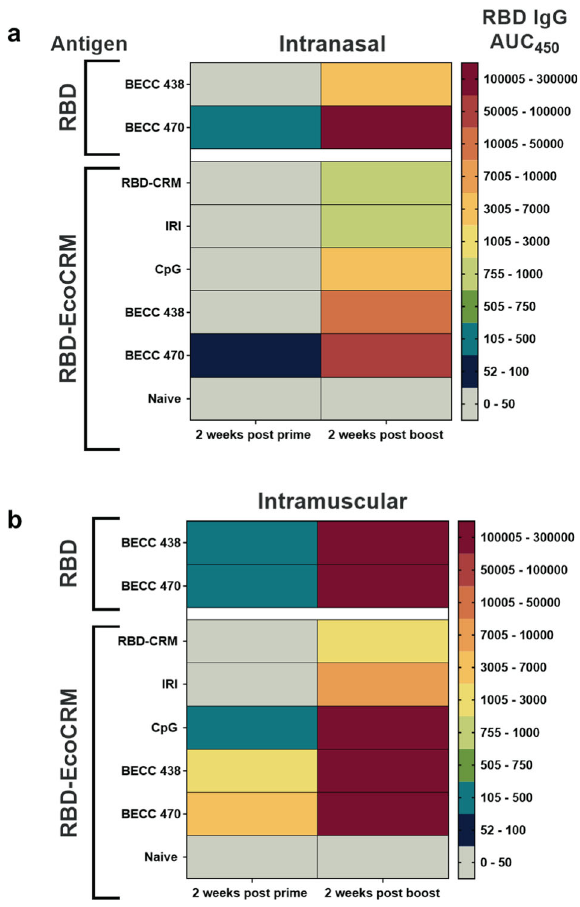
Fig. 1 Mouse immunogenicity studies to identify vaccine candi- dates. 7 COVID-19 vaccine formulations were administered intrana- sally ( a ) or intramuscularly ( b ) in CD-1 mice in two doses. Heat map depicts the AUC450 values from RBD-IgG titers at 2 weeks post prime (left) and 2 weeks post boost (right). The maximum AUC450 value is set at 300,000, and the minimum is at